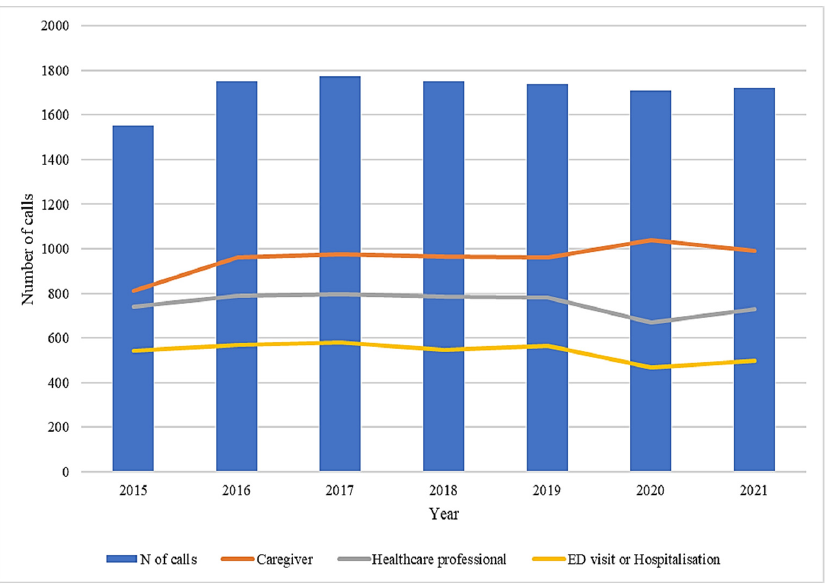
Figure 1. Distribution of calls, qualification and ED visits or hospitalizations during the study period (years 2015–2021).